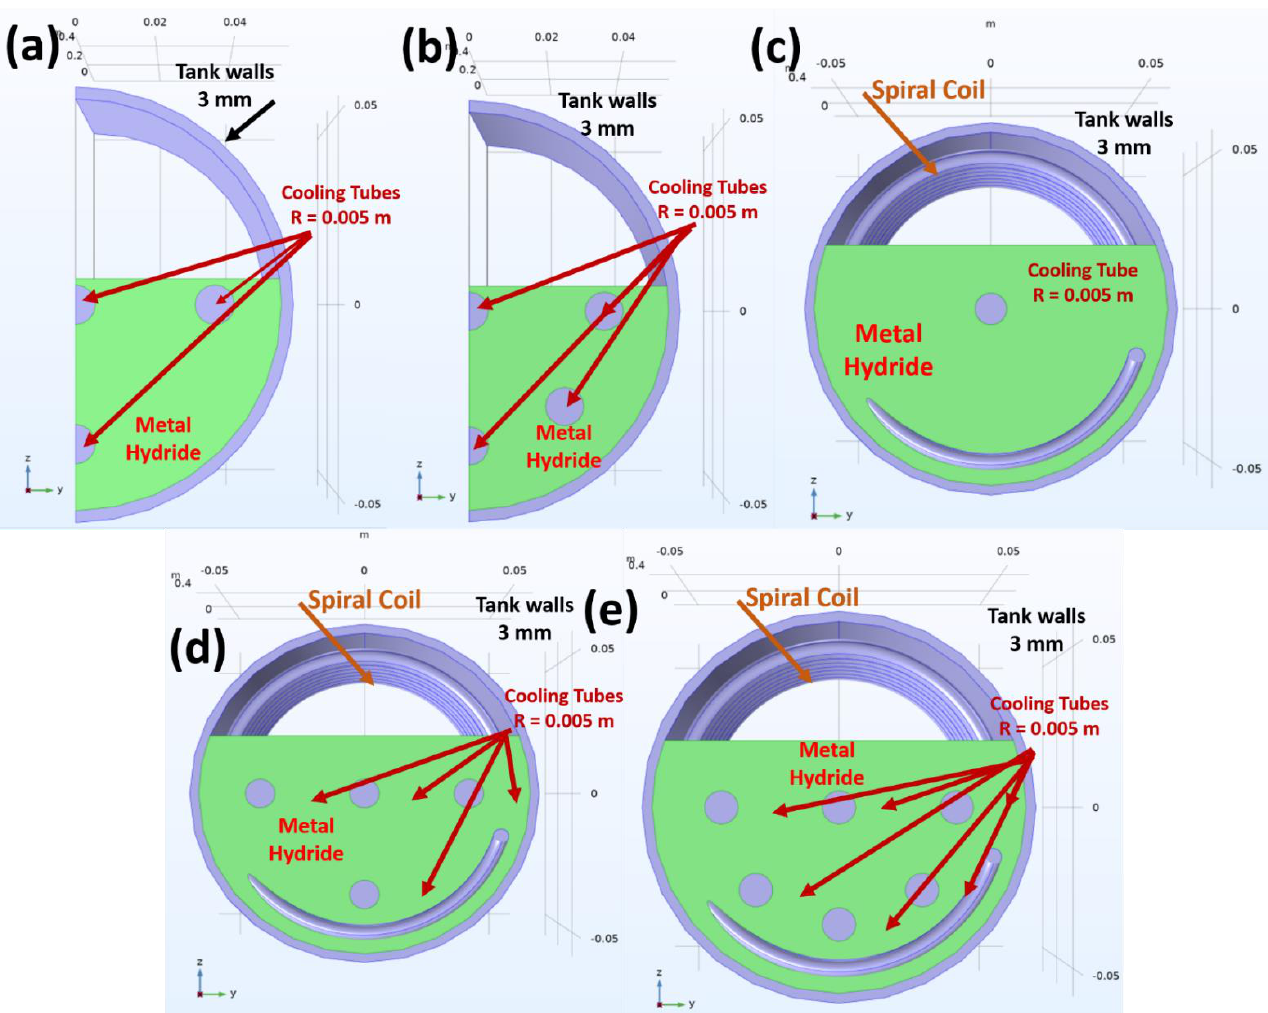
Figure 1. Tank design geometries: ( a ) is the base line scenario with four embedded cooling tubes; ( b ) has six cooling tubes. For a more homogeneous temperature distribution; ( c – e ) include a spiral coil along with the embedded cooling tubes. Table 1. Details of all the tank geometries used in the current